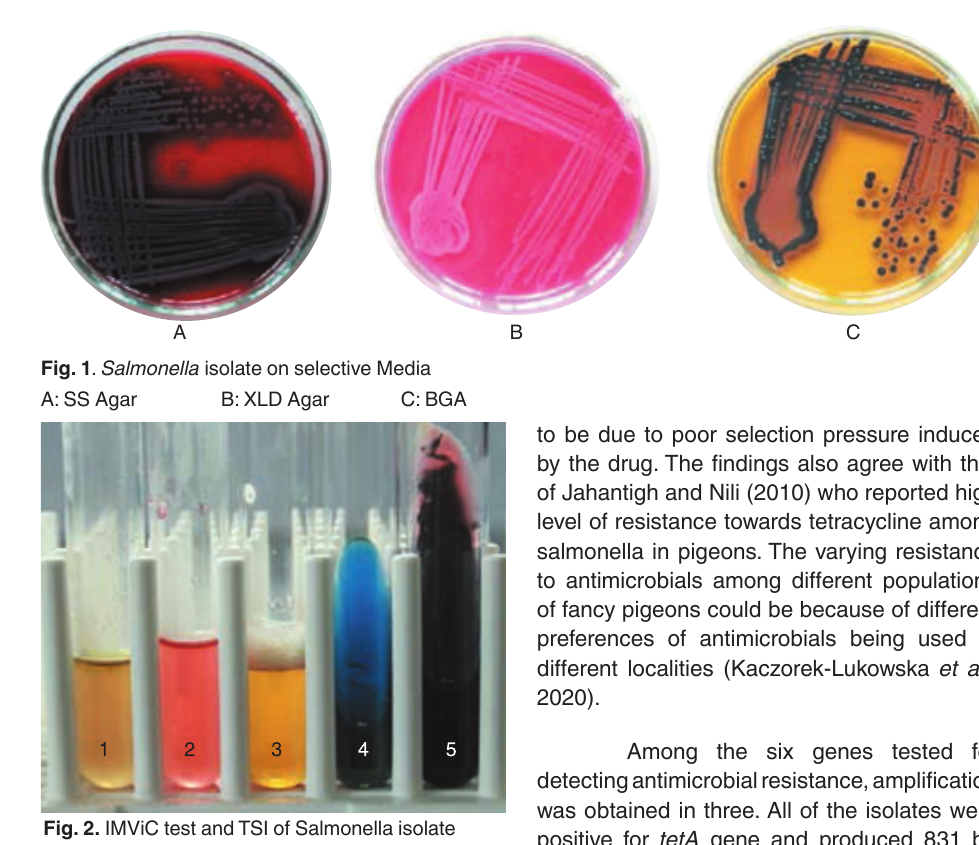
Fig. 2. IMViC test and TSI of Salmonella isolate